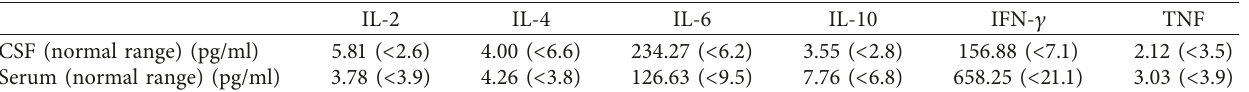
Figure 4: Histopathology of myocardium (on day 25 of the illness). There was no finding of the infiltration of the inflammatory cells. The myocardial cell had variation in the size and irregular adhesion, and fibrosis was seen between the muscular fiber. These were not findings of the acute phase but chronic stage, which were delivered by the pressure overload of the right ventricle due to the pulmonary arterial stenosis. Hematoxylin eosin, × Table 1: Cerebrospinal fluid and serum cytokine data.